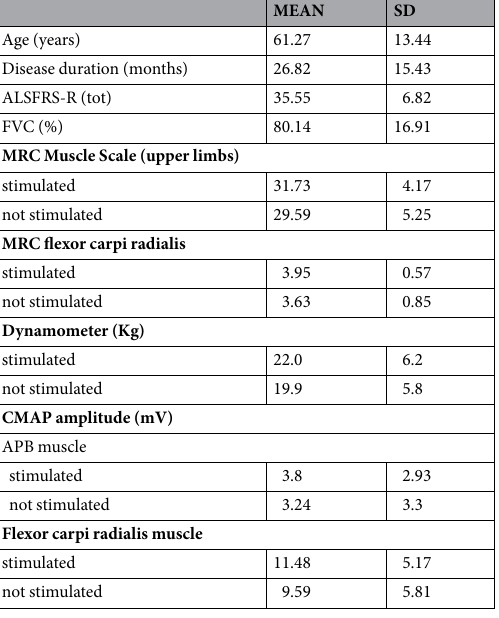
Table 1. Clinical characteristic at T0 of the 22 patients included in the study (19 males. 3 females). Data are expressed as mean ± standard deviation